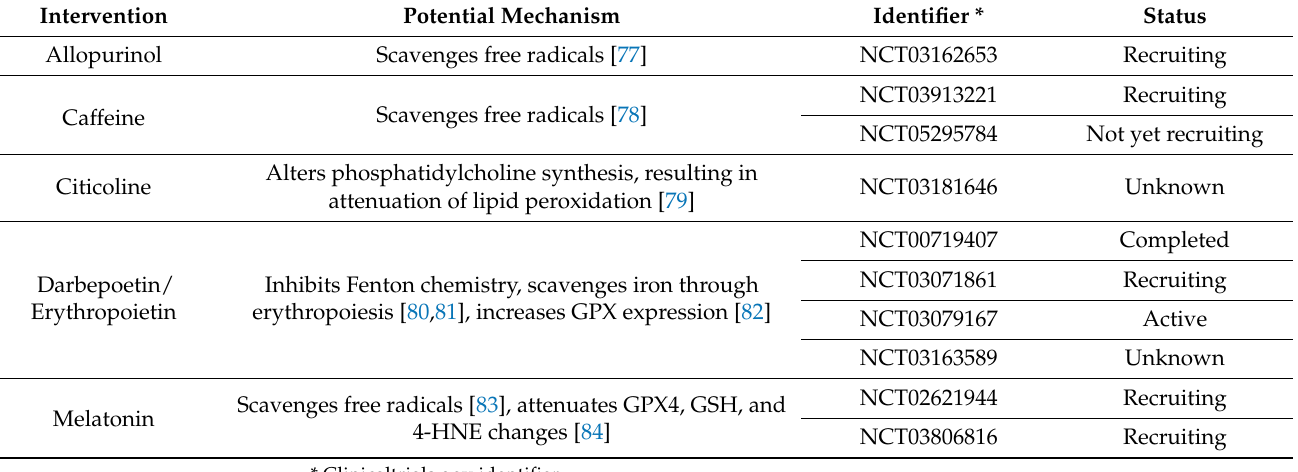
Table 1. Ongoing clinical trials (or completed trials without published results) assessing interventions that may affect ferroptosis in neonatal hypoxic-ischemic brain injury. List reflects studies registered with Clinicaltrials.gov as of June